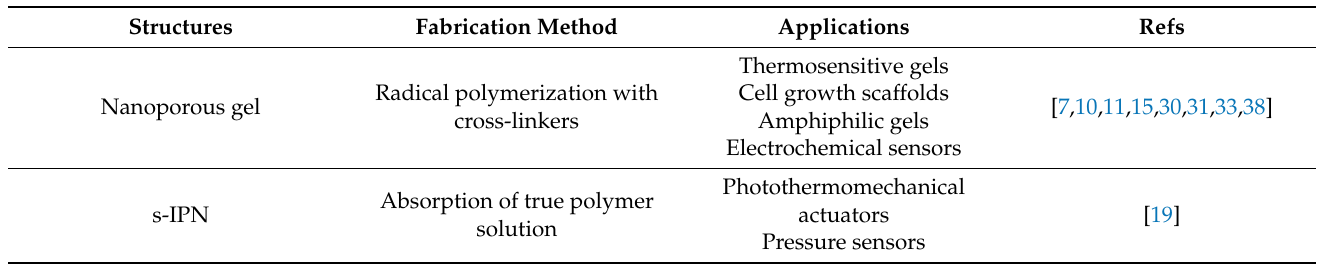
Table 1. Fabrication methods of gels and